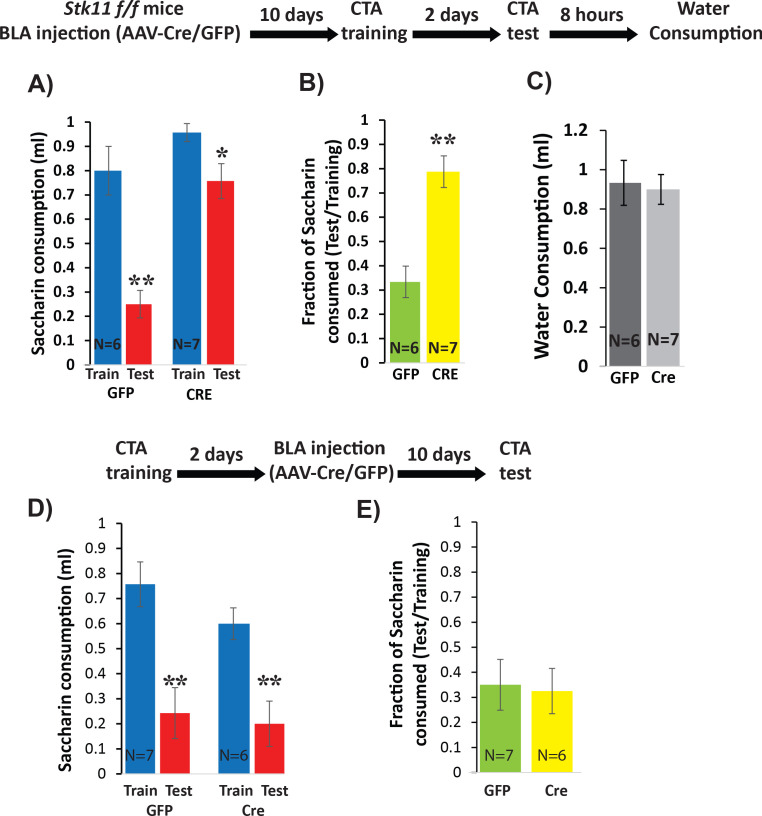
Deletion of Stk11 from BLApn impairs CTA learning.(A) Stk11f/f mice were infected with Cre or control viruses 10 days before CTA training and were tested 48 hr later. Despite significant reduction in saccharin consumption between testing and training sessions in control mice, Stk11 KO animals showed almost no learning. Mixed ANOVA revealed significant training and genotype effects (training: F(1,11) = 42.1; p=4.5×10−5; genotype: F(1,11) = 18.2; p=0.001; as well as a significant interaction: F(1,11) = 9.2, p=0.012). Post-hoc analysis (Bonferroni corrected) revealed that although both GFP (N = 6) and Cre (N = 7) reductions following CTA (test vs. train) were significant (GFP: p=0.003; Cre: 0.013), there was a large and significant difference in saccharin consumption between GFP and Cre groups during the test (GFP: 0.25 ml; Cre: 0.75 ml; p=2.1×10−4), while differences in saccharin consumption during training were not significant (p=0.15). (B) Control animals (GFP) consumed only 33% of the training amount during the test, but KO mice (Cre) consumed 78% and this difference was significant (t(11)=-4.91; p=4×10−4). (C) Reduced saccharin consumption does not reflect an overall reduction in drinking measured 8 hr later (t(11)=0.25; p=0.87). **p<0.01. (D) Stk11 deletion after long-term memory formation has no effect on CTA retention. Stk11 f/f mice received Cre and control viruses 2 days after CTA training and were tested 10 days later. Mixed ANOVA revealed a significant effect of training (F(1,11) = 48.8, p=2.3×10−5) but no significant effect of genotype (F(1,11) = 1.7, p=0.23) or interaction (F(1,11) = 0.76, p=0.40). Post-hoc analysis confirmed significant reductions in both groups following CTA (GFP: N = 7, p=0.003. Cre: N = 6, p=0.002). There was no significant difference between GFP and Cre groups during training (p=0.19) or during the test (p=0.64). (E) There was no significant difference in CTA intensity as measured by the fraction of saccharin consumed (t = −0.18, p=0.86). **p<0.01. See also Figure 4—source datas 1–4 and Figure 4—figure supplement 1.Figure 4—source data 1.Saccharin consumption (ml) during CTA training and test.This data relates to Figure 4 panel A.Figure 4—source data 2.Fraction of saccharin consumed (Test/Training).This data relates to Figure 4 panel B.Figure 4—source data 3.Saccharin consumption (ml) during CTA training and test.This data relates to Figure 4 panel D.Figure 4—source data 4.Fraction of saccharin consumed (Test/Training).This data relates to Figure 4 panel E.